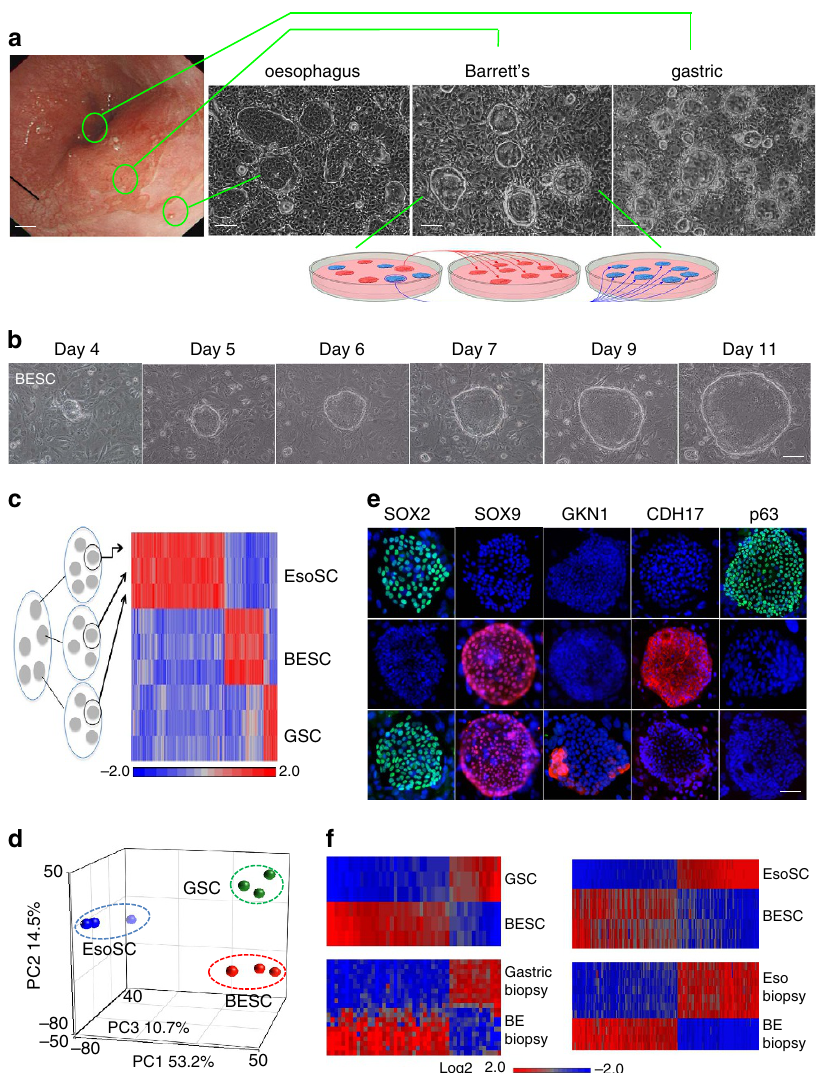
Figure 1 | Stem cells from the distal oesophagus of Barrett’s patient. ( a ) Left, Endoscopic image of distal oesophagus of a Barrett’s patient and approximate locations of biopsies. Right, phase contrast images of typical colonies derived from biopsies. Inset diagram, schematic of cloning process to yield Barrett’s or oesophageal stem cell pedigrees from mixed population from Barrett’s biopsies. Scale bar, 150 m m. n ¼ 12 biological replicates. ( b ) Colony formation from a single stem cell over indicated days in culture. Scale bar, 50 m m. ( c ) Heatmap of differential gene expression of three independent pedigrees from each of oesophageal (EsoSC), Barrett’s (BESC) and stomach (GSC) stem cells. ( d ) PCA of expression data of three pedigrees each of oesophageal, Barrett’s and stomach stem cells. ( e ) Representative immunofluorescence labelling of colonies of EsoSC, BESC and GSC with antibodies to the indicated marker proteins (green or red) with nuclei counterstained with DAPI (blue). Scale bar, 50 m m. n ¼ 12 biological replicates. ( f ) Gene expression heatmap comparing those differentially expressed between immature GSC ( n ¼ 3) and Barrett’s stem cells (BESC; n ¼ 3) with those from endoscopic gastric biopsy and Barrett’s biopsies (BE-biopsy) (GSE34619) (ref. ALI cultures (Fig. 2e), the Barrett’s and stomach stem cells and their corresponding ALI-differentiated epithelia show similar patterns as expected for columnar epithelia, while the oesophageal stem cells and their differentiated epithelia occupy different expression spaces consistent with their squamous properties. However, in vitro -differentiated epithelia from these stem cells expressed distinct gene expression signature that is consistent with their tissue origin (Fig. 2f). Together, these data Fig. 3, Supplementary Table 1 and Supplementary Data 1). This support the conclusion that we have identified and cloned distinct degree of differential gene expression is similar to that found stem cells of the oesophagus, stomach and Barrett’s epithelia. between stem cells from the upper and lower airways 18 or between stem cells of the duodenum and jejunum 16 . Extending this analysis, we also found that Barrett’s stem cells had whole- genome expression profiles that could be readily distinguished from those of both stomach and intestine by PCA and by gene